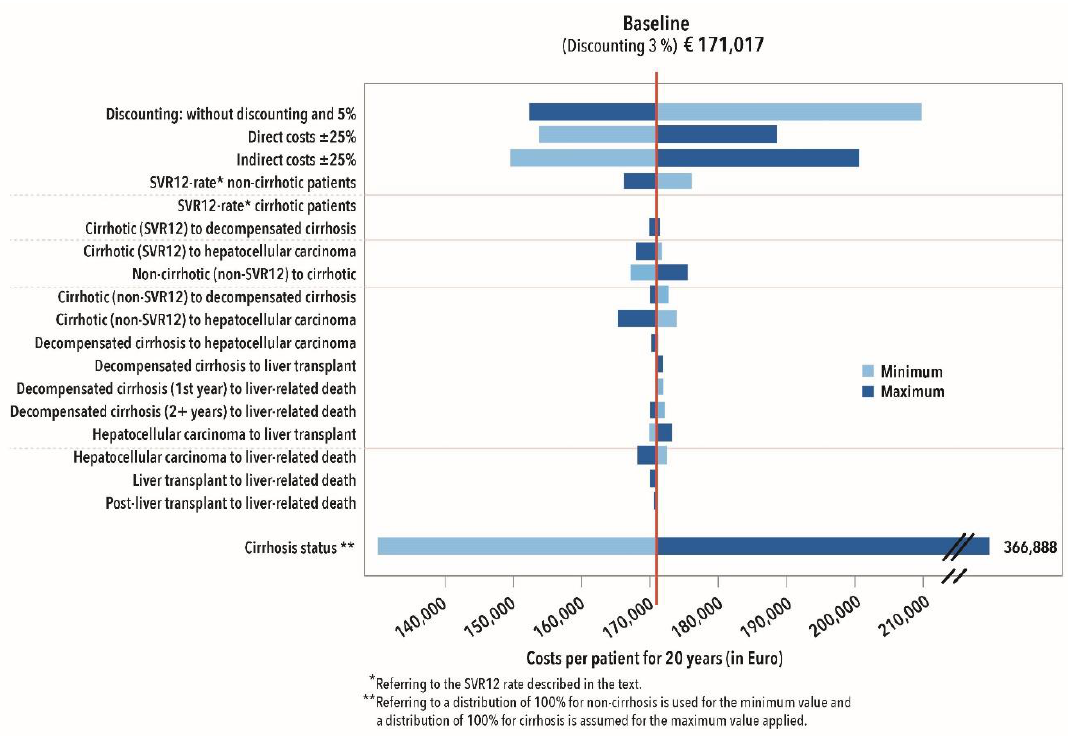
Figure 5. Deterministic sensitivity analysis of interferon-based triple therapies.